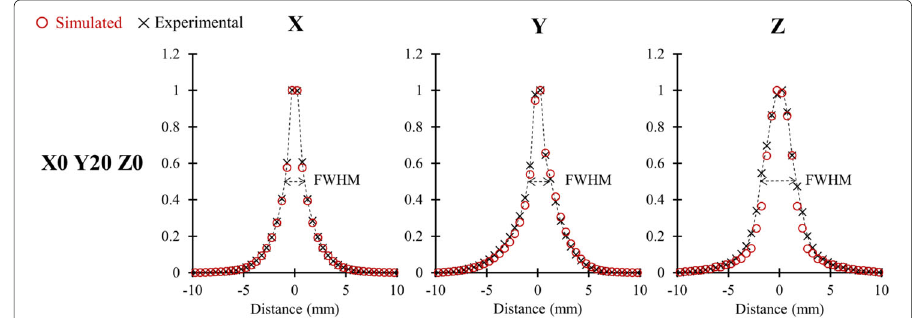
Fig. 6 Example of histograms and corresponding FWHM of the shortest distances between source and LORs projected along the X , Y , and Z axis, obtained from experimental and simulated data